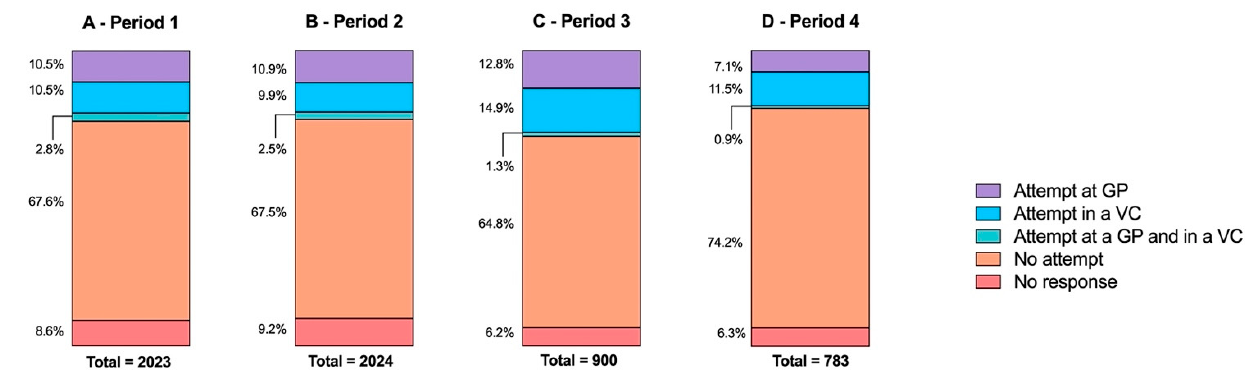
Figure 4. Respondent attempt to receive COVID-19 vaccination depending on survey period (A—period 1, from 16 March to 10 April; B—period 2, from 11 April to 30 April; C—period 3, from 1 May to 30 May; D—period 4 from 31 May to 30 June). GP— general practitioner; VC—vaccination center.